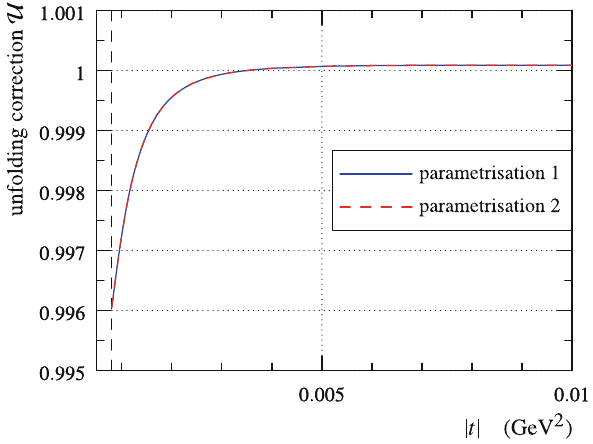
Fig. 9 Unfolding correction as a function of | t | . The vertical dashed line indicates the position of the acceptance cut. The two correction curves were obtained with different fit parametrisations used in step 1 (see